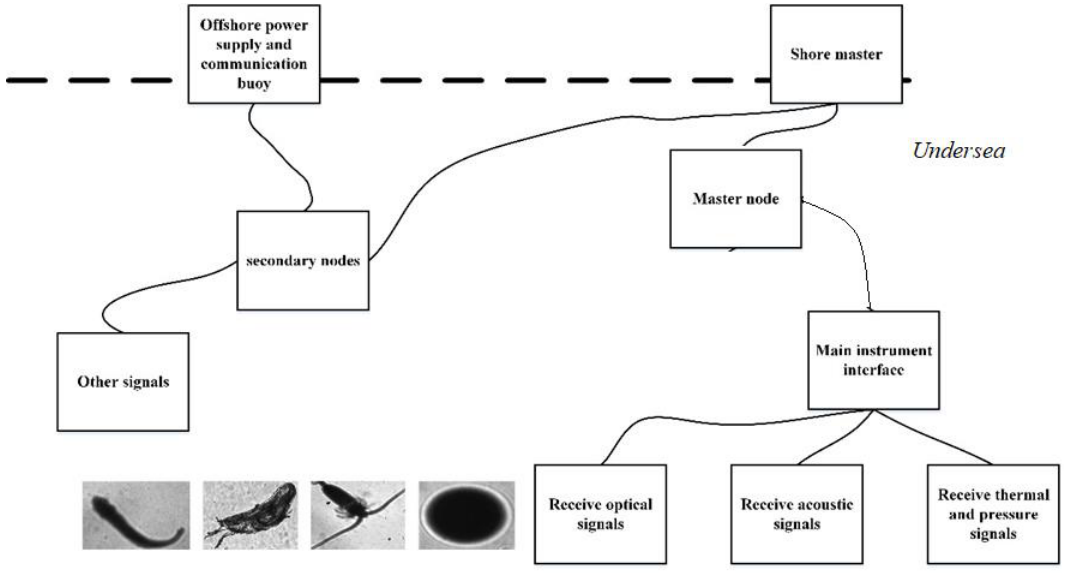
Figure 10. Diagram of undersea observation network.